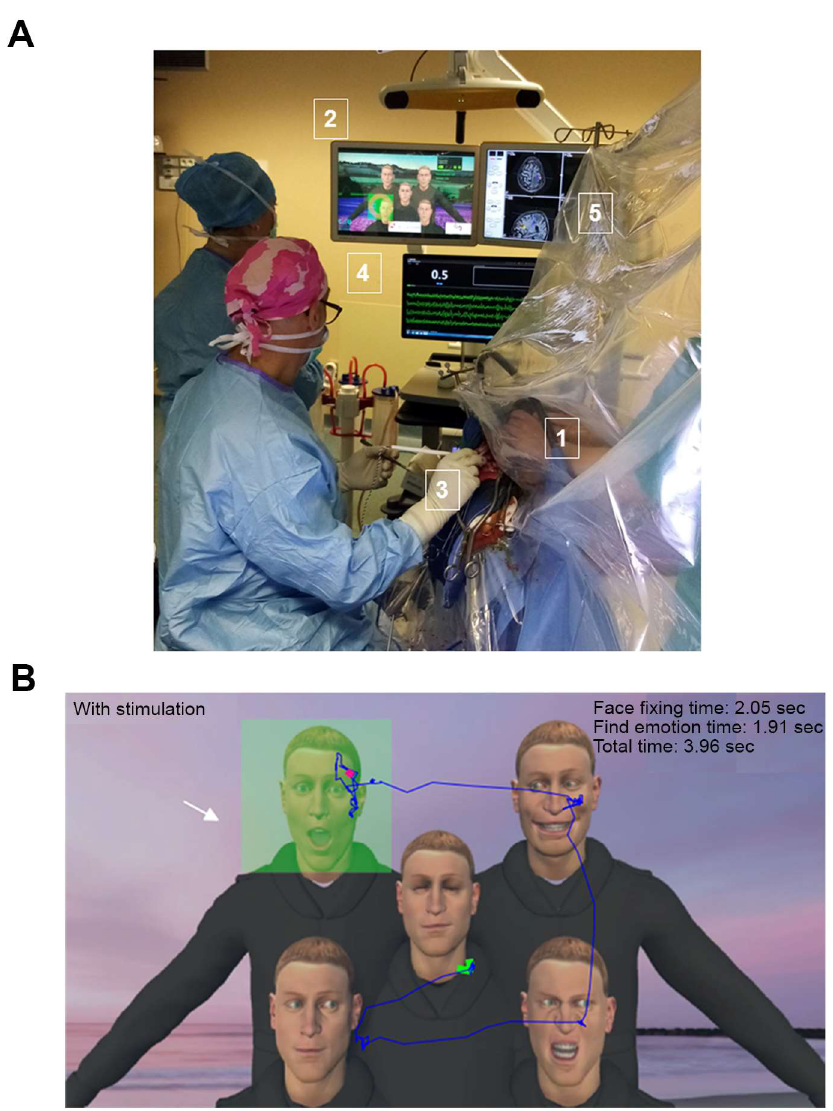
Figure 1. Intraoperative procedure with VR tasks. ( A ) View of the operative room during the procedure (1: head of the patient, wearing the VRH; 2: screen showing what the patient is seeing in the VRH, his gaze materialized by a green spot; 3: application of DES to the exposed brain; 4: screen showing EEG signals; 5: neuronavigation showing white matter fascicles and the position of the electrode). ( B ) Example of the VR task simulating a social interaction (VR-TANGO). The patient is asked to search for the avatar trying to make visual contact and to indicate the emotion expressed on the avatar’s face (joy, surprise or anger). The patient’s gaze is indicated by a blue line. The green square indicates the avatar making eye contact. The arrow indicates the avatar that the patient gazed at for more than 0.6 sec (thereby triggering the dynamic facial emotion). In this example, the patient identified the avatar making eye contact in 2.05 sec and indicated the emotion expressed 1.91 sec later. (EEG, electroencephalogram; VRH, virtual reality